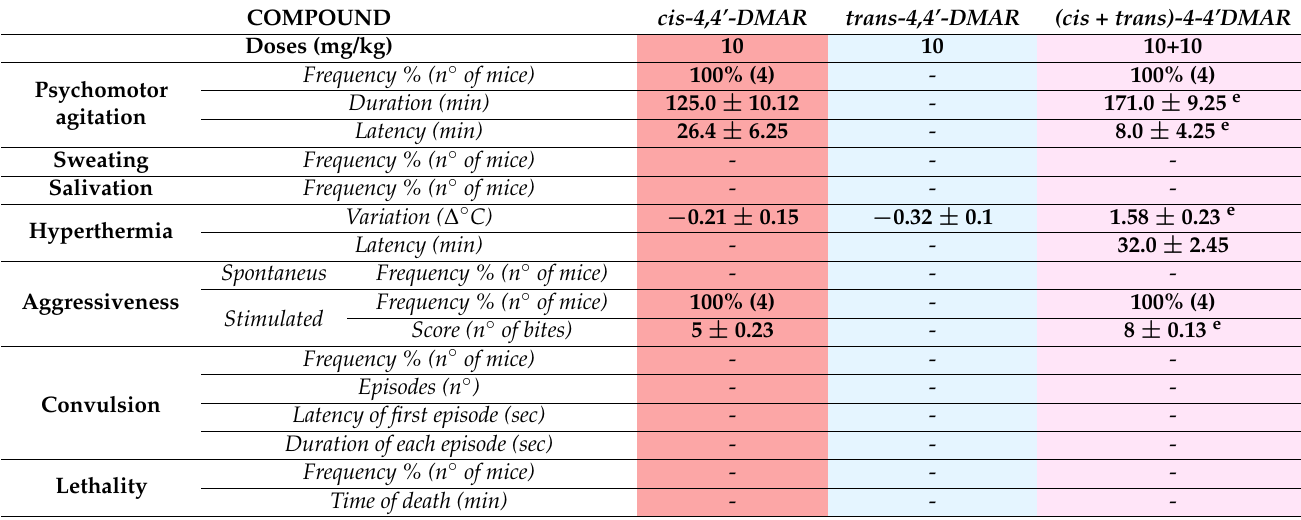
Table 4. Effect of co-administration of ( ± ) cis -4,4 (cid:48) -DMAR (10 mg/kg i.p.) and ( ± ) trans -4,4 (cid:48) -DMAR (10 mg/kg i.p.) on neuro- behavioural changes (psychomotor agitation, aggressiveness, convulsion), physiological alterations (sweating, salivation, hyperthermia) and death in mice. Data expressed (see material and methods) represents the mean ± SEM of four animals for each treatment. The statistical analysis of the effects of the interactions between ( ± ) cis -4,4 (cid:48) -DMAR and ( ± ) trans -4,4 (cid:48) -DMAR were performed using a one-way ANOVA followed by a Bonferroni test for multiple comparisons. A Student’s t -test was used to determine statistical significance ( p < 0.05) between the two groups. e p < 0.05, versus cis 10